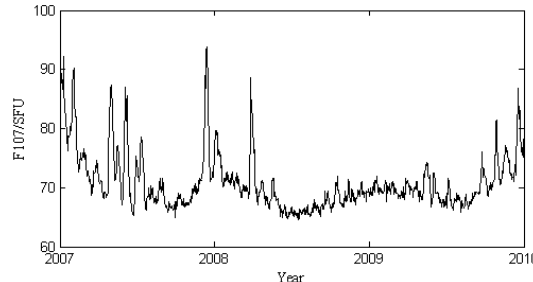
Table 1. The locations of the GPS stations.